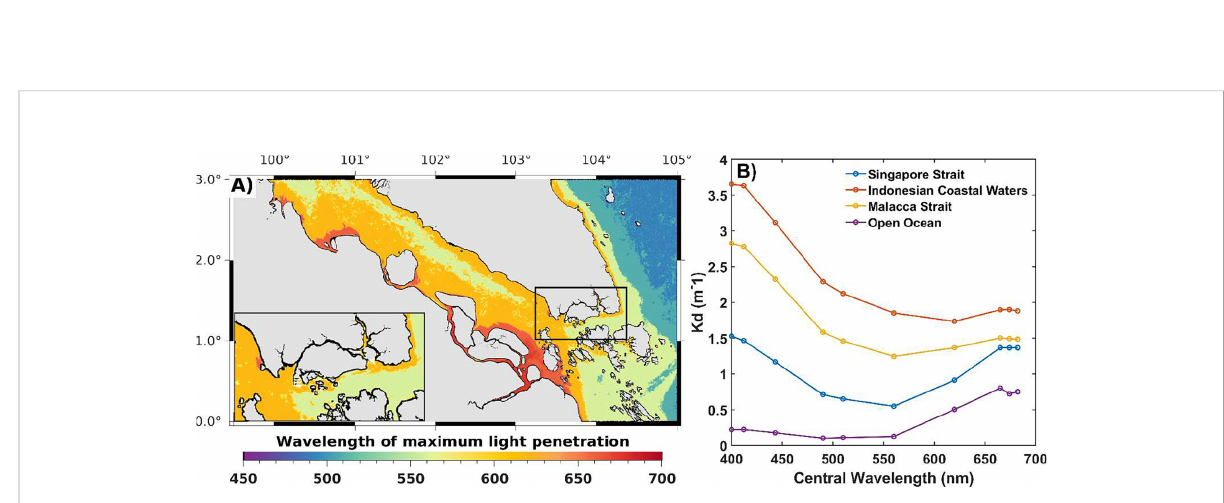
FIGURE 8 Spectral quality of light in the water column. (A) Spatial distribution of the mean value (2017 – 2020) of the central wavelength at maximum penetration of light. (B) Spectral distribution of light across Singapore Strait, Malacca Strait, Open Ocean, and Sumatran Coastal